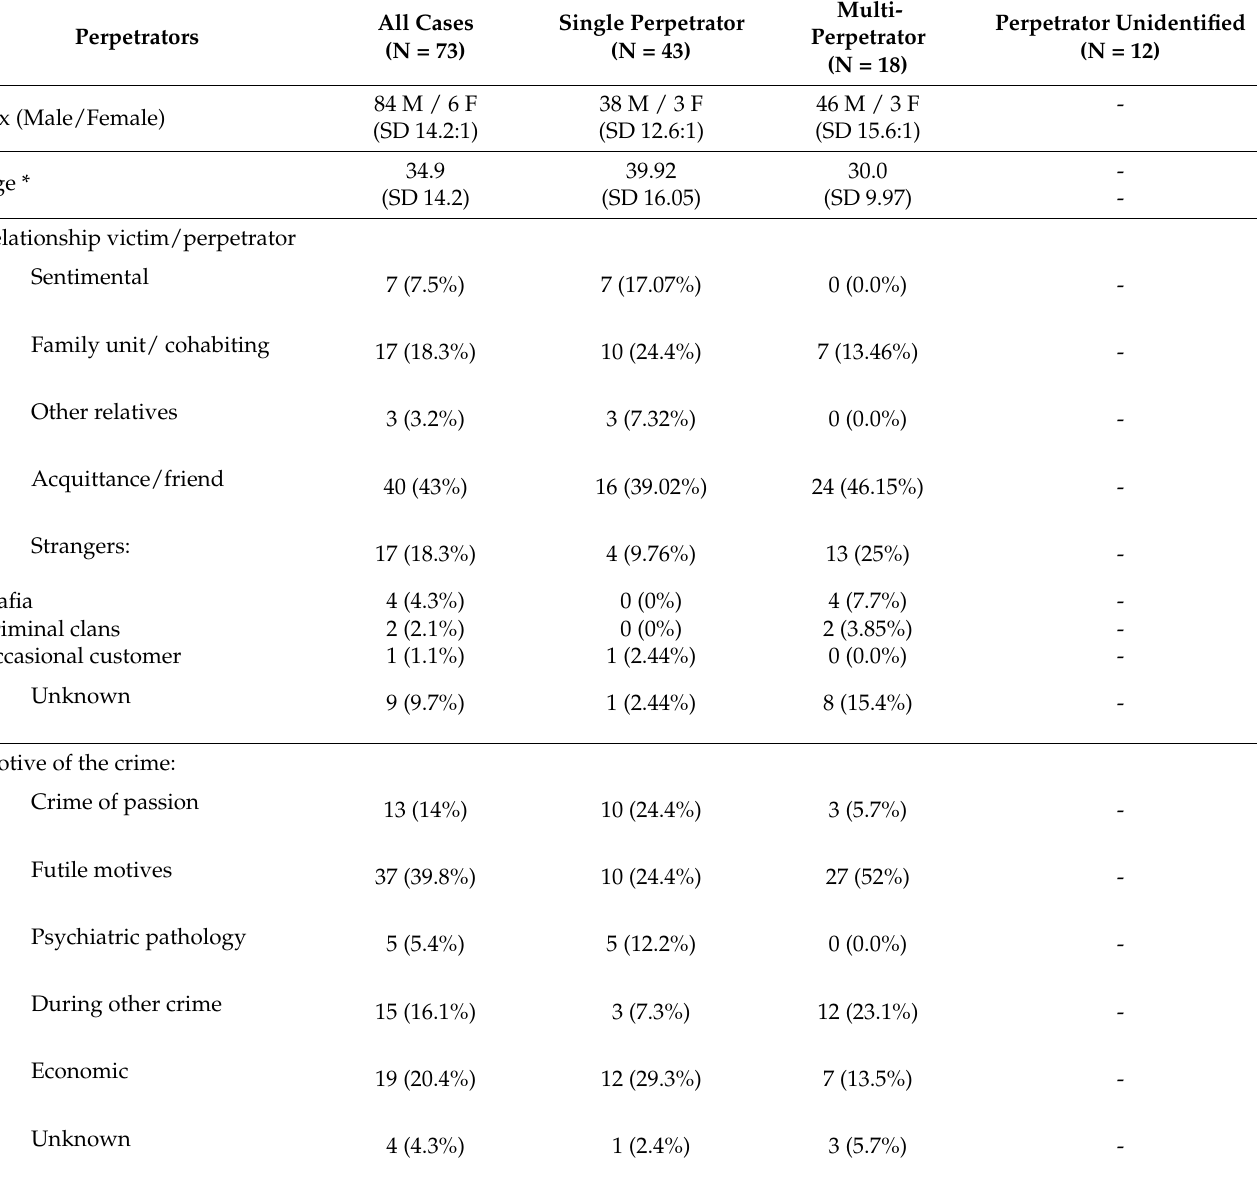
Table 3. Descriptive statistics of the